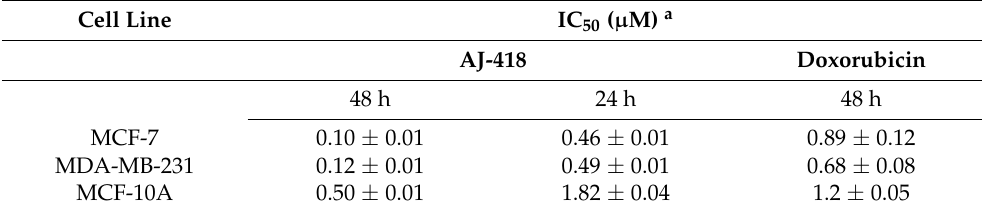
Table 1. Cell viability of MCF-7, MDA-MB-231 and MCF-10A cells after 48 h and 24 h incubation with AJ-418 , assessed using the MTT test.